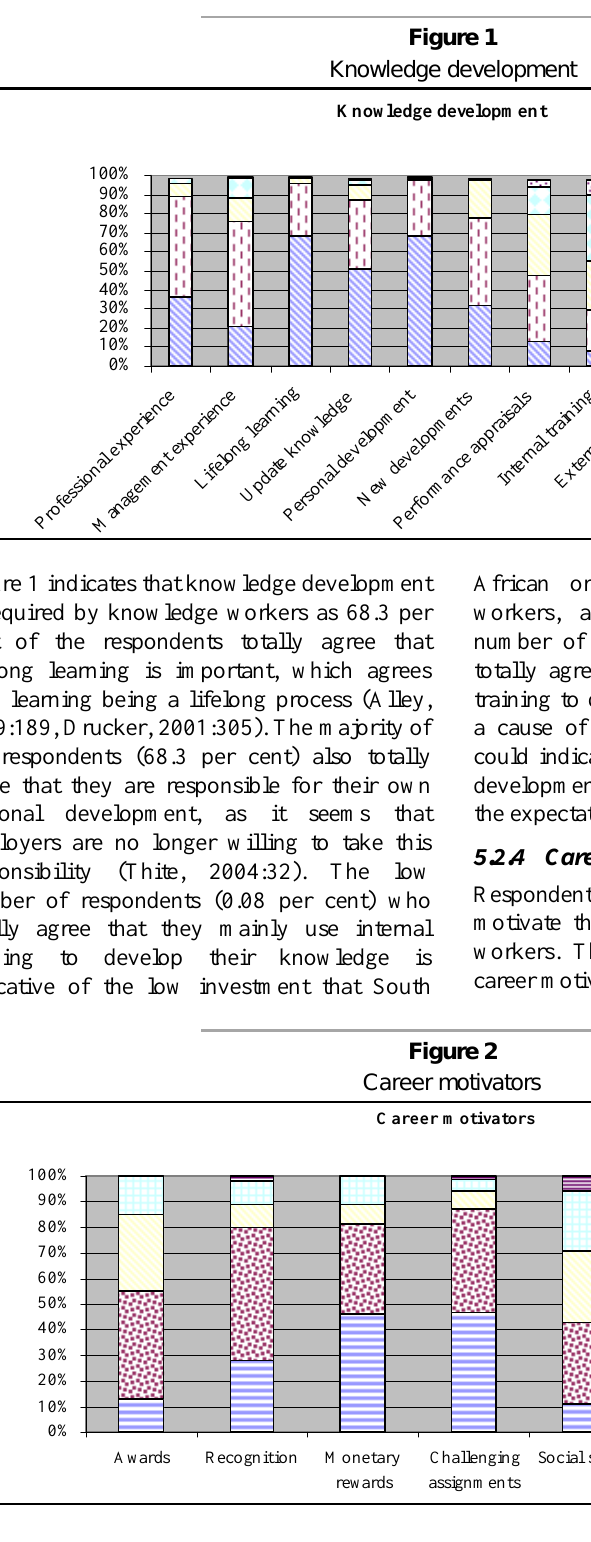
Figure 1 Knowledge development Knowledge development